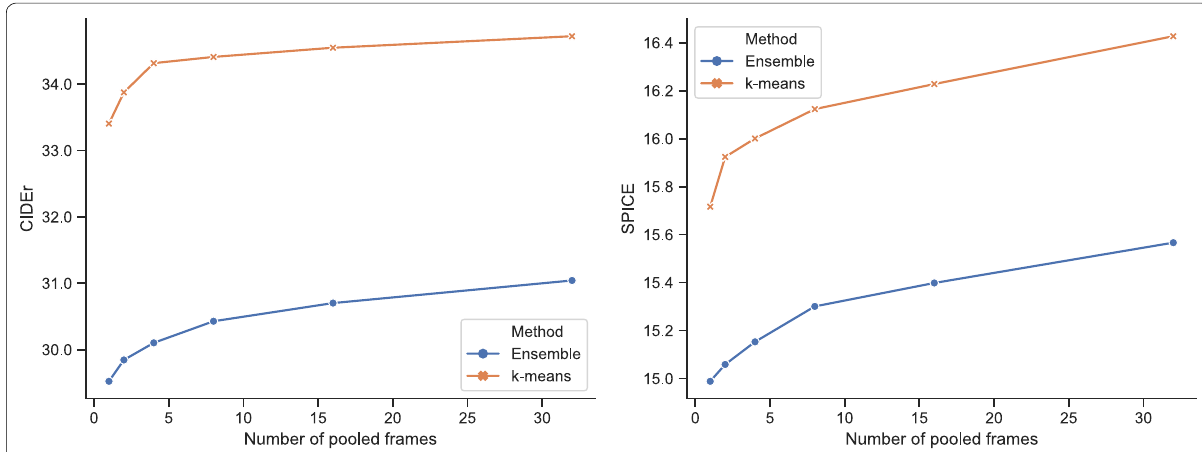
Fig. 10 CIDEr-D and SPICE scores with temporal batch clustering. The number of frames to be obtained is investigated among { 1,2,4,8,16,32,64 }